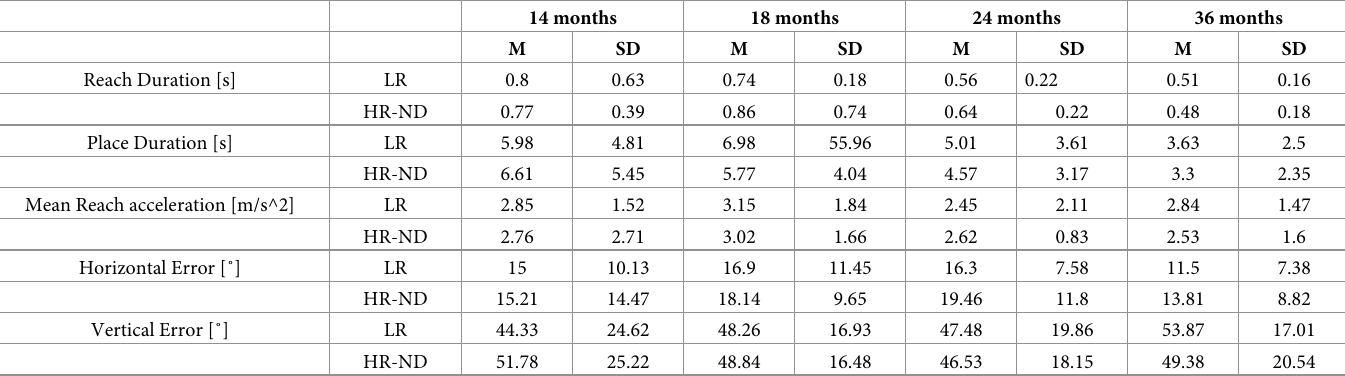
Table 1. Mean and standard deviations for all variables at all ages.